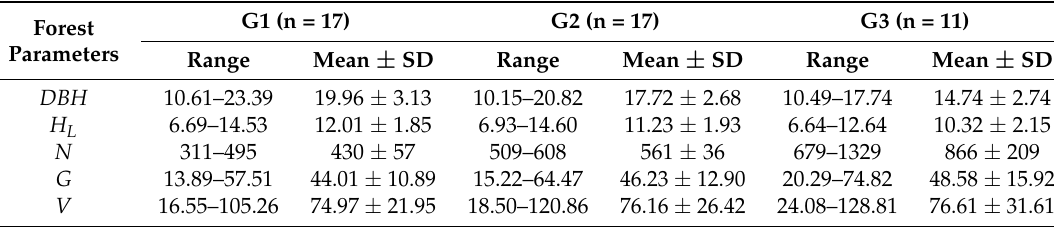
Table 1. Summary statistics of field measured forest structural attributes in the study site (n = 45, radius = 15 m).